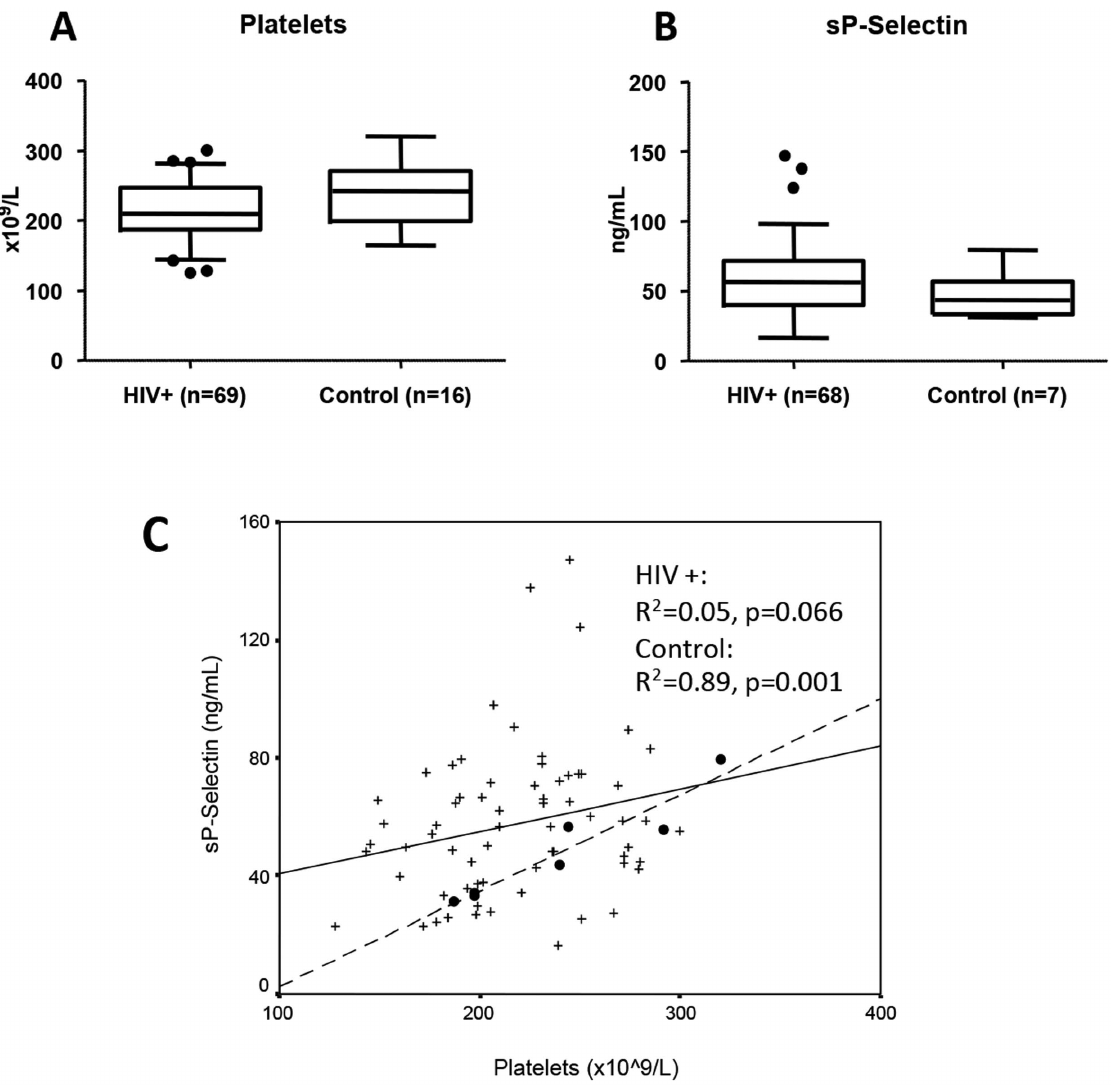
Figure 2. Levels of platelets (A) and sP-Selectin (B) in HIV infected patients (HIV + ) after 12 years of successful cART compared to HIV negative controls. Means were compared using Mann-Whitney test and depicted as boxplots with Tukey whiskers (1.5 times the interquartile N distance or to the highest or lowest point, whichever is shorter). *=p , 0.05, **=p , 0.001. Below (C), scatter plot of correlation between platelet and , dotted line). R 2 and P values were calculated using linear sP-Selectin concentrations in HIV infected patients ( + , full line) and healthy controls ( regression.